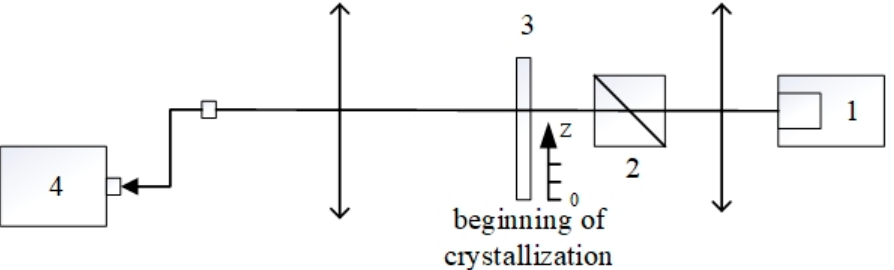
Figure 1. The experimental setup for registration of the absorption spectrum of the samples. (1) broadband StellarNet halogen and deuterium light-source; (2) Glan–Taylor prism; (3) the sample; (4) CCD StellarNet spectrometer. The samples were moved along the z -axis that is perpendicular to the probe